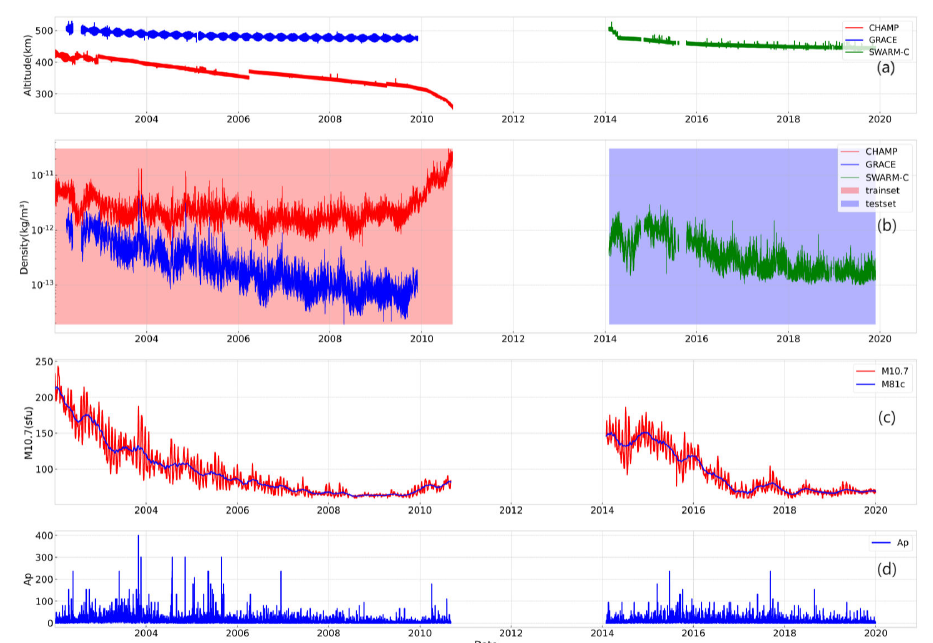
Figure 1. ( a ) The altitudes of CHAMP (red line), GRACE-A (blue line), SWARM-C (green line) and GRACE-FO (yellow line), ( b ) thermospheric density measured by the three satellites, ( c ) daily solar radio flux M10.7 (red line), 81-day average of solar M10.7c (blue line) and ( d ) geomagnetic activity Ap index.